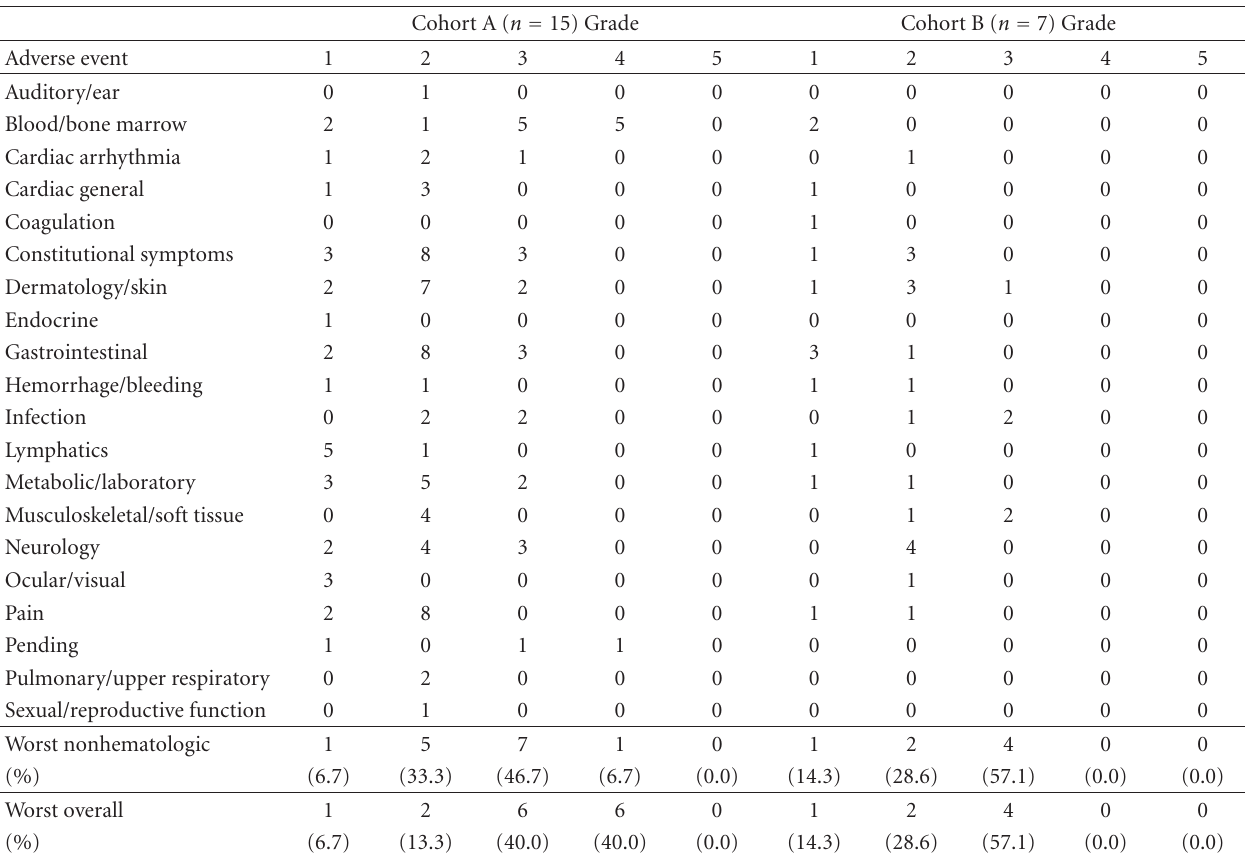
Table 2: Nonthromboembolic adverse events for cohort A and B patients in RTOG 0330.